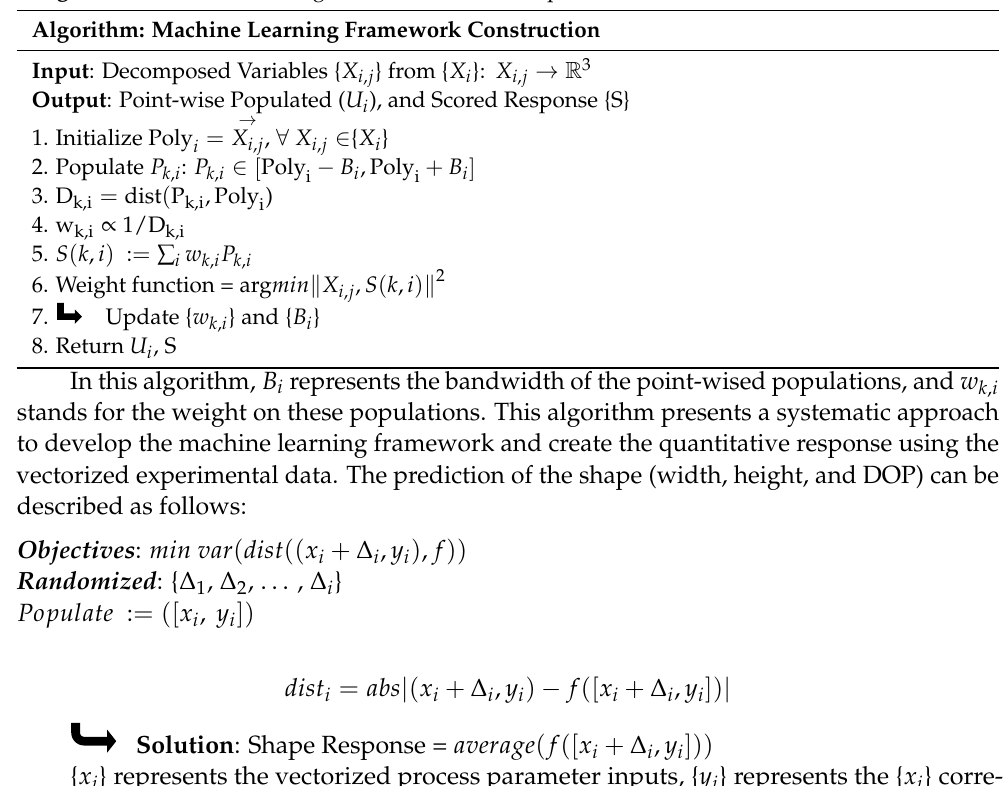
Table 3. ANOVA analysis of parameter’s effect on bead height.